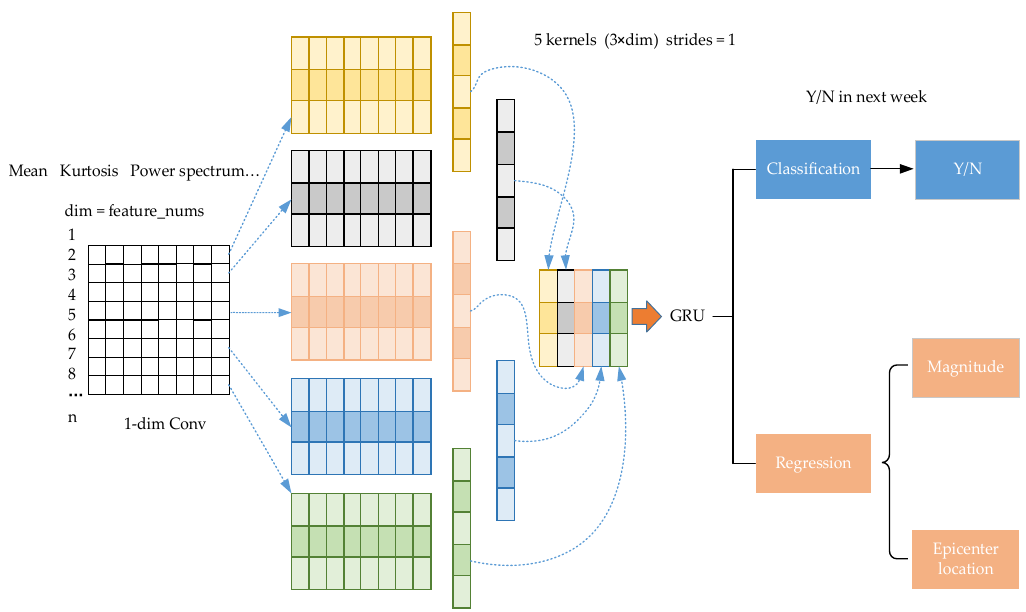
Figure 7. CNN+GRU stacking network architecture.